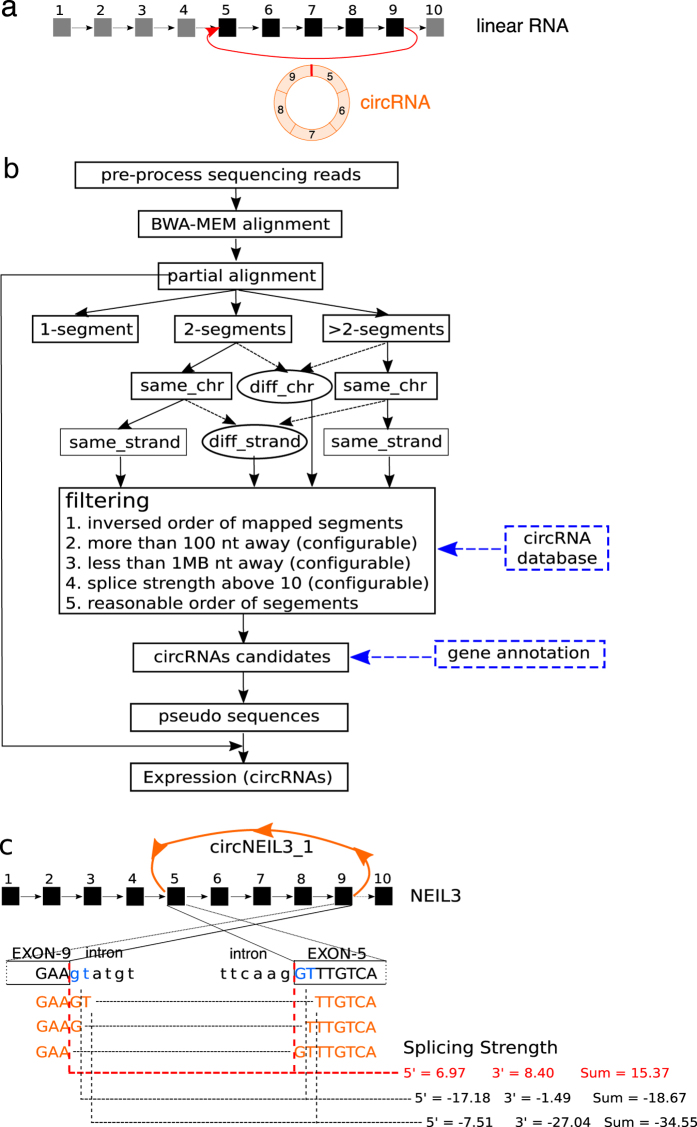
Computational pipeline of circRNA profiling.(a) An example of a circRNA (colored in orange) originated from a multi-exonic gene locus (black squares). The red vertical bar on the circRNA marks the BSJ. (b) Schematic workflow of acfs, ovals denote processes for fusion circRNA identification, dashed boxes denote optional input. (c) Determination of the BSJ using circ_NEIL3 as an example. The BSJ supporting read can be partitioned in three manners (colored in orange) due to the sequence similarity at the splice sites. Exon sequences are shown in upper case, and intron sequences are shown in lower case. Splice strength is estimated for each of the potential splice sites using the maxEnt model. One partition pattern (red dash-line) is predicted to be generated by the splicing machinery and is reported as the BSJ.